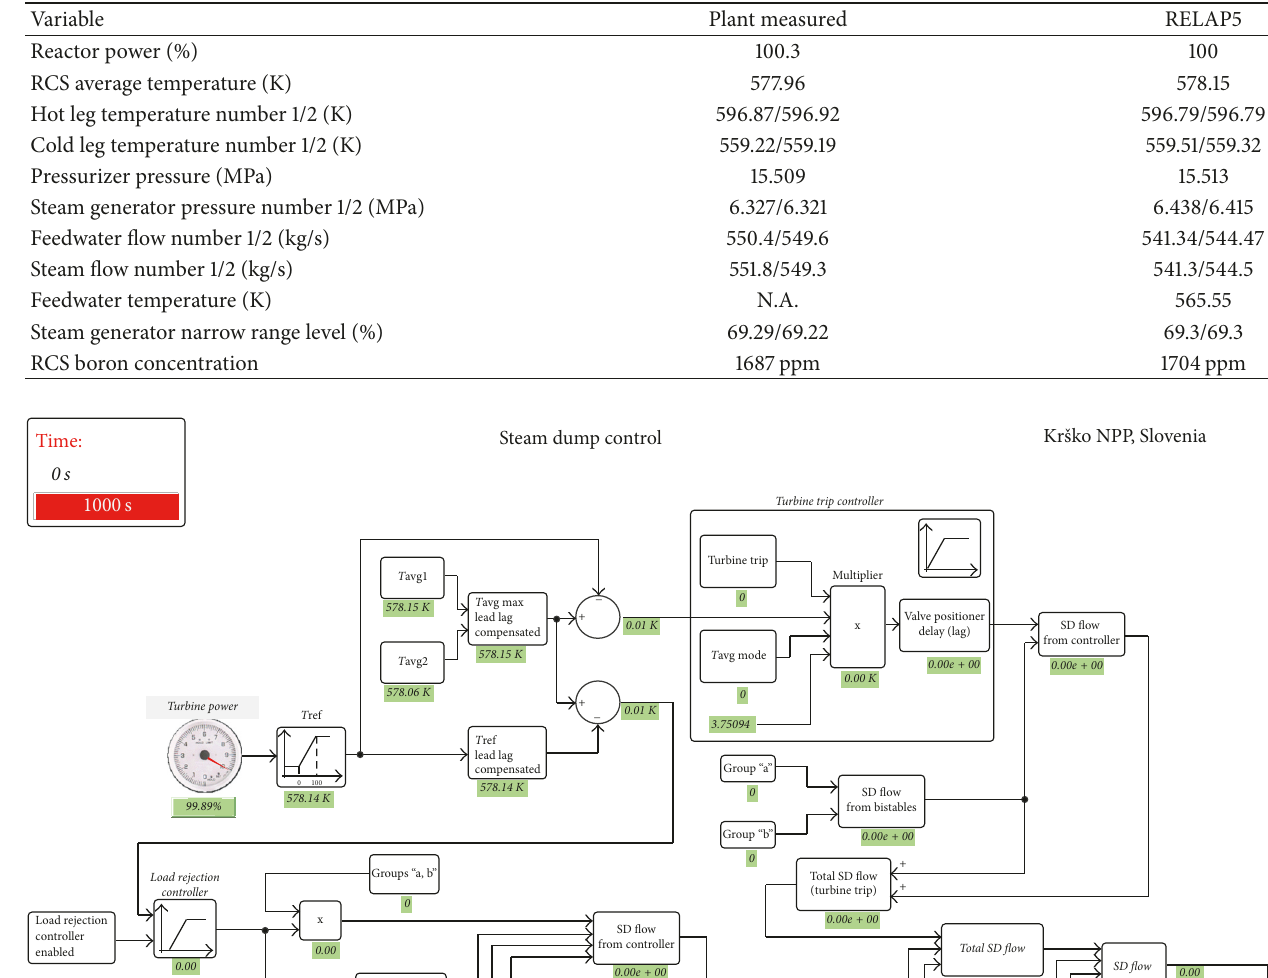
Table 2: Initial conditions.